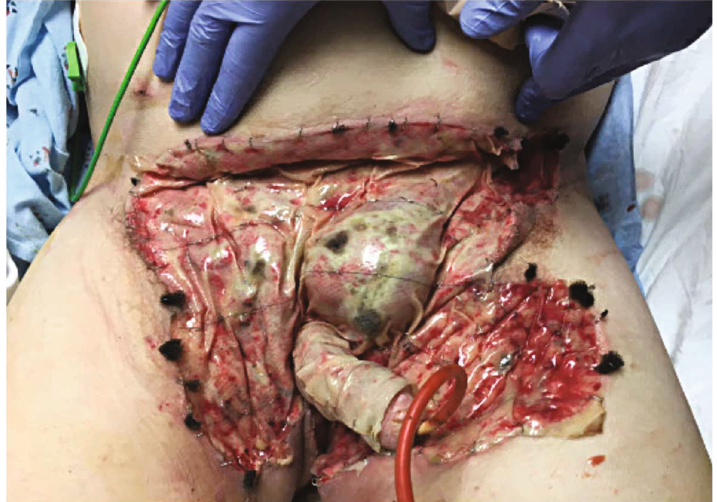
Figure 4: POD 7 from incision and debridement of the penis and scrotum, scrotectomy, and bilateral orchiectomy. POD 2 from colostomy creation, excision of condyloma, sharp debridement with Integra graft application, and wound vac placement. Photo taken after wound vac was